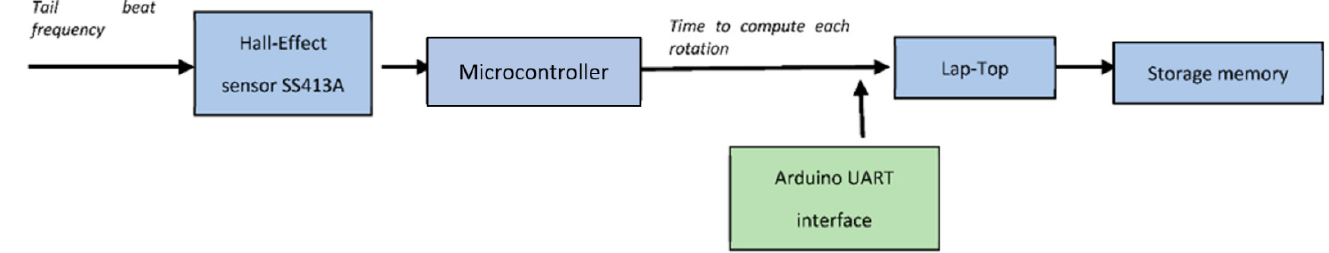
Figure 8. Rotations per second of the magnetic disc were recorded using a hall-effect sensor (SS413A), while data were read with a microcontroller (Arduino Mega board). Then, data were transmitted in real time to a laptop by means of the universal asynchronous receiver–transmitter (UART) interface of the microcontroller.